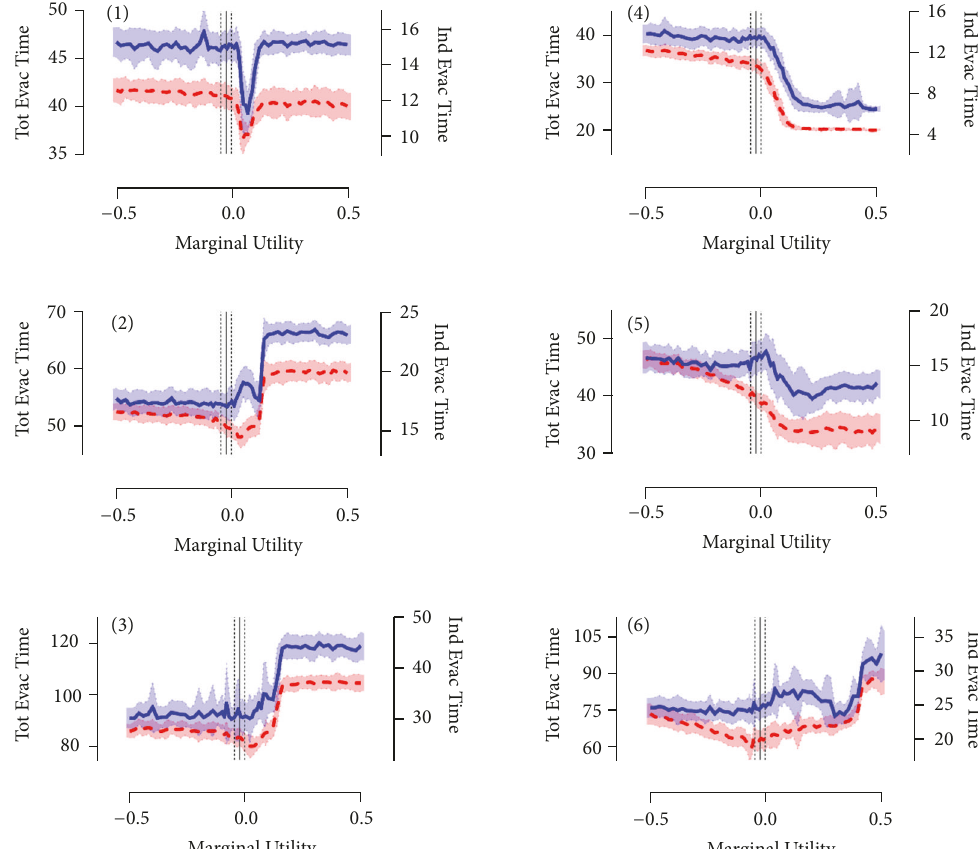
Figure 12: Variations of the simulated total evacuation times (blue solid lines; left vertical axis) and simulated average individual evacuation times (red dashed lines; right vertical axis) as a result of changes in the marginal utility of FLTOINVIS attribute in exit decision-making of the simulated evacuees. Error bands show the standard deviations of the measurements. The vertical solid lines represent the empirically estimated value for the marginal utility of FLTOINVIS, and the vertical dashed lines visualise the 95% confidence interval of that